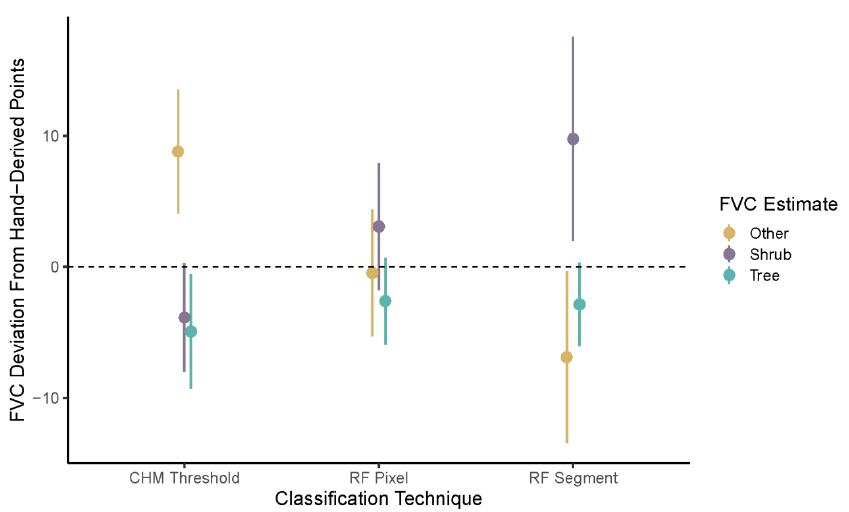
Figure 6. Mean relative difference in FVC classification technique as compared to the expert, image- based delineation of reference points. Confidence intervals (95%) that do not cross the dotted line indicate a statistically significant difference for each FVC estimate for a given classification approach and the by-hand